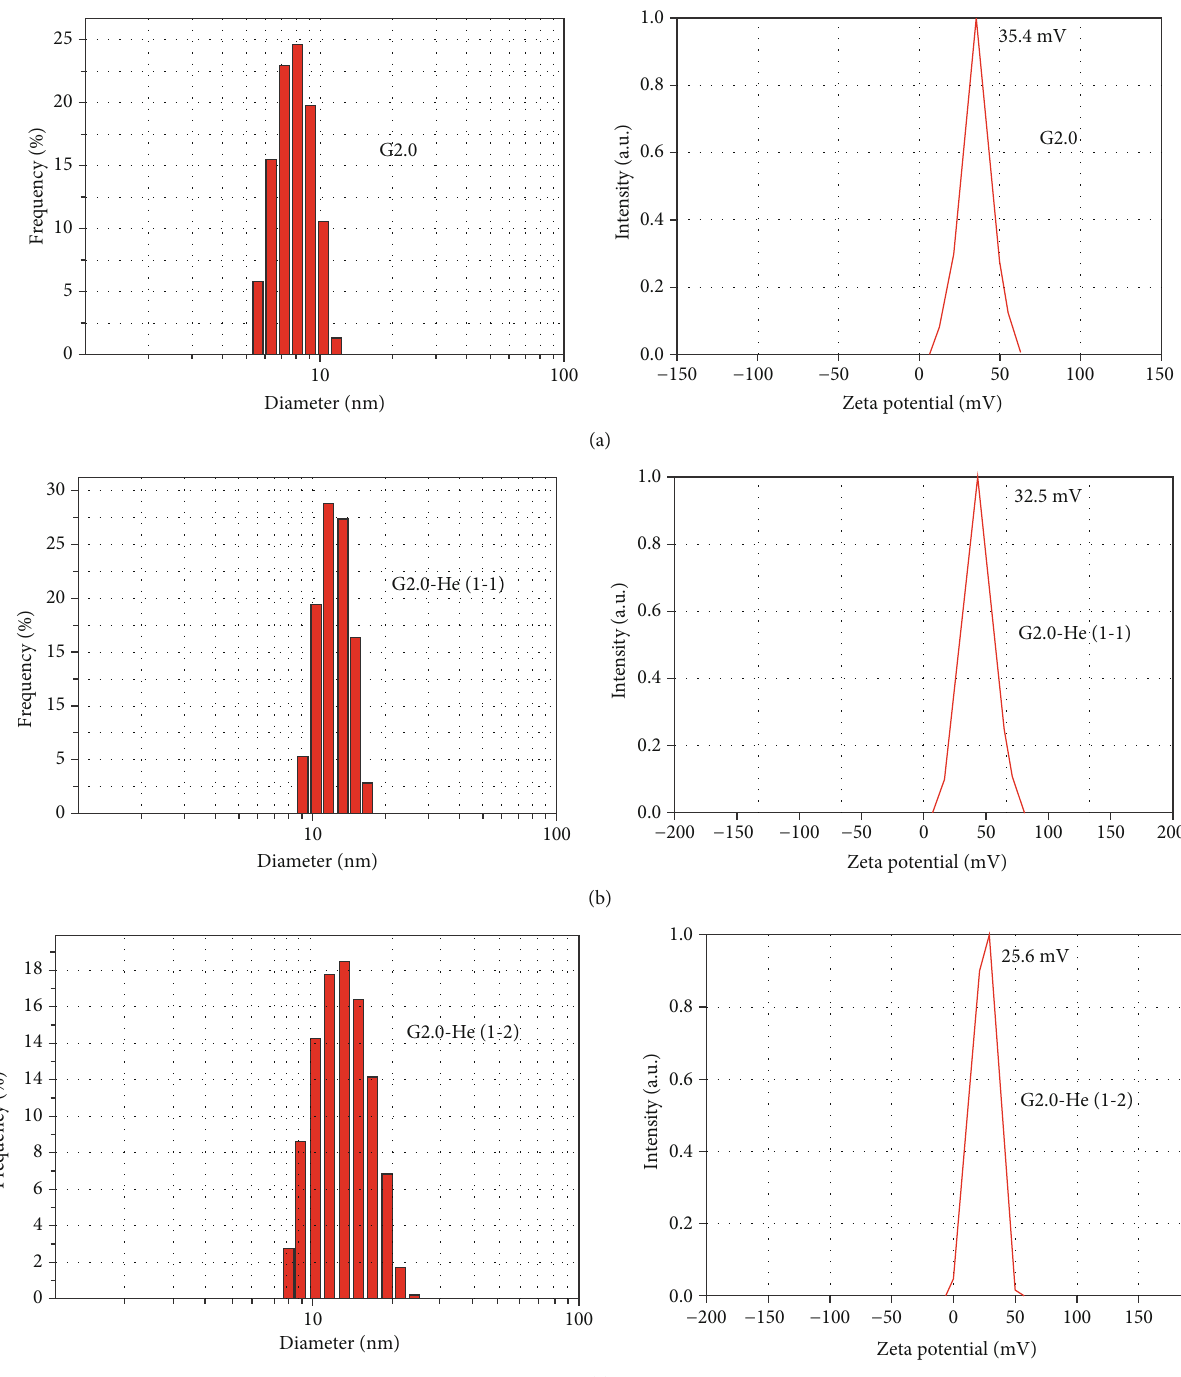
Figure 4: Size distribution and zeta potential: PAMAM G2.0 (a), G2.0-He (1-1) (b), and G2.0-He (1-2)